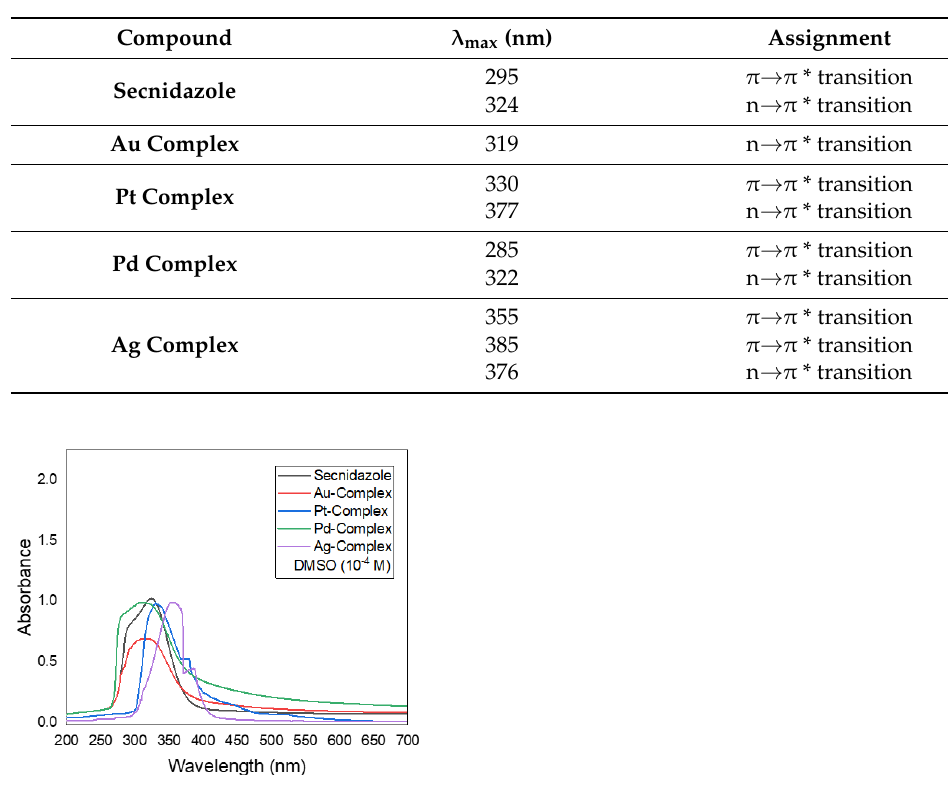
Table 3. The electronic spectral data of the free secnidazole ligand and its complexes.